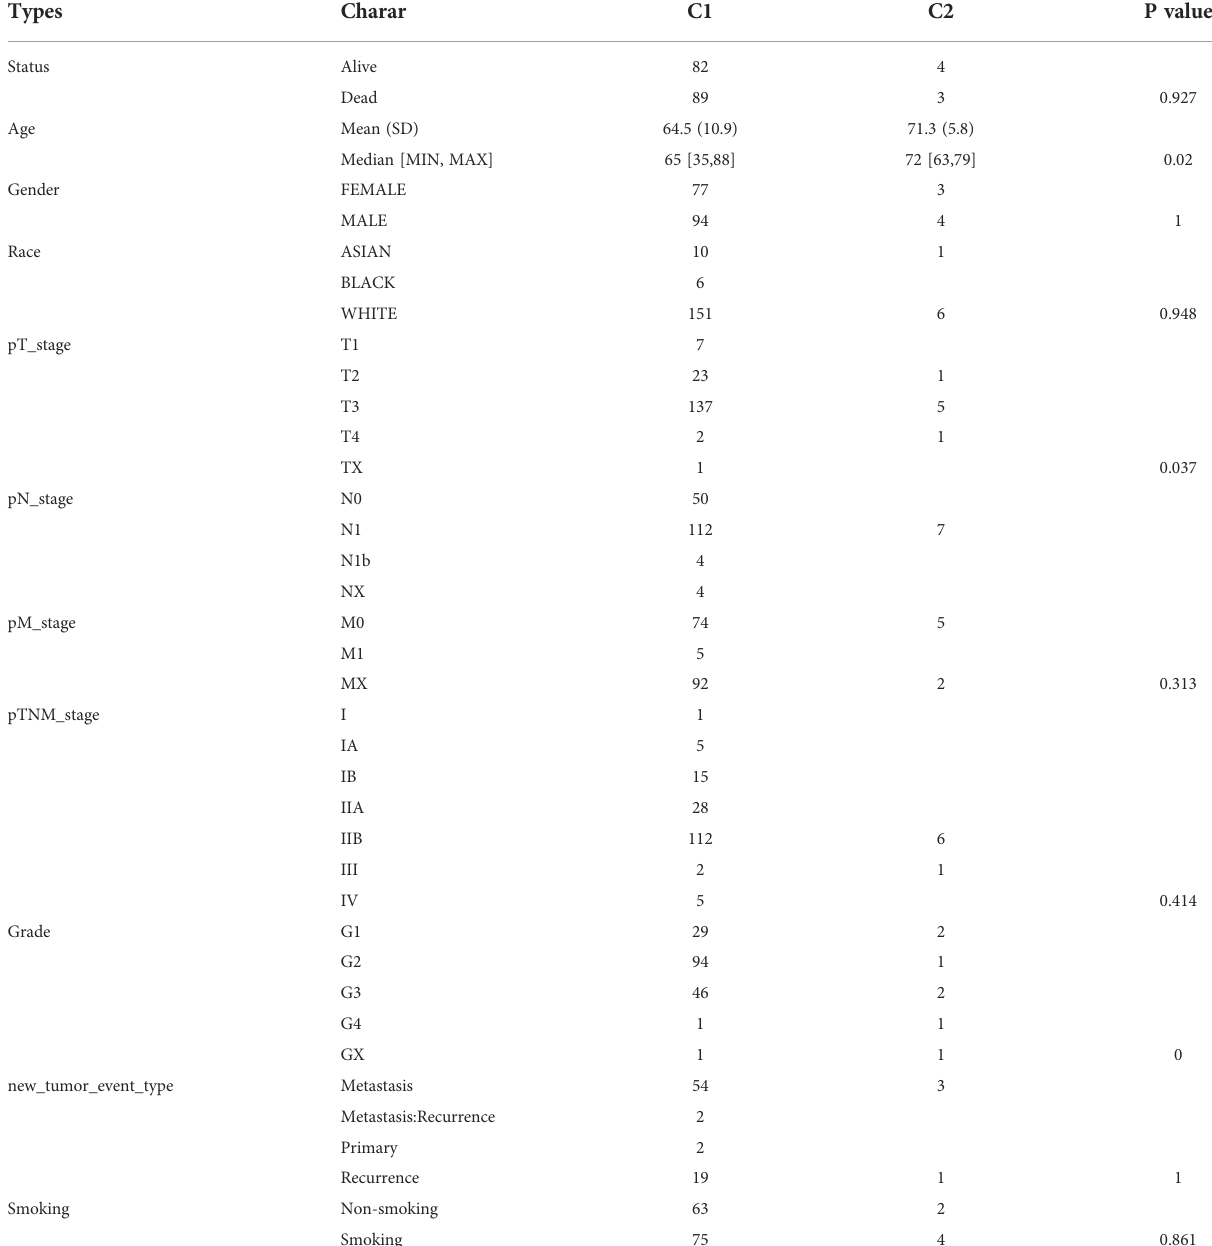
TABLE 1 Comparison of clinical